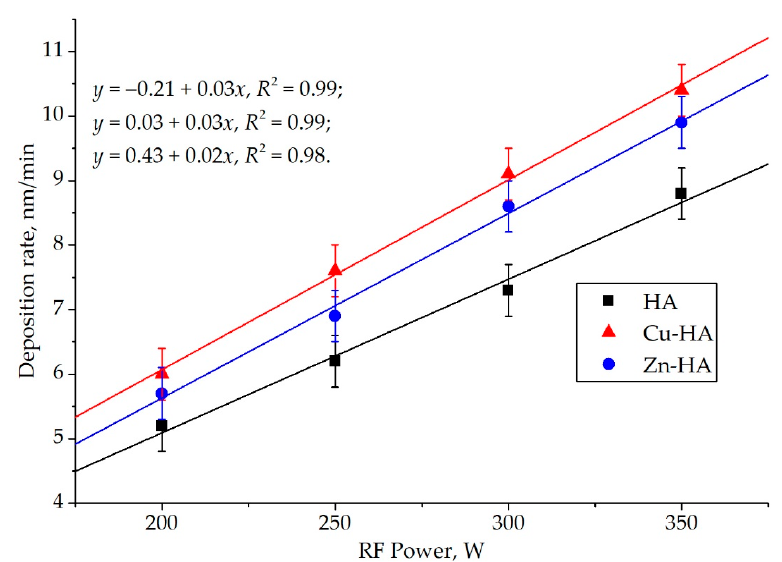
Figure 7. Coating growth rate obtained by sputtering of HA, Zn-HA, and Cu-HA targets vs. applied RF power. As was shown earlier, the XRD and apparent density of the target material are sig- nificantly higher for Cu-HA and Zn-HA compared to stoichiometric HA. Therefore, it is assumed that in addition to the binding energy of atoms in substituted HA that is majorly governing the sputtering yield, a significant role is played by target density, which results in the modulation of the deposition rate. Figure 8a shows the thickness distribution of the RF magnetron coatings obtained during the sputtering of the Cu-HA target for three hours. The throw distance in this case was 70 mm.